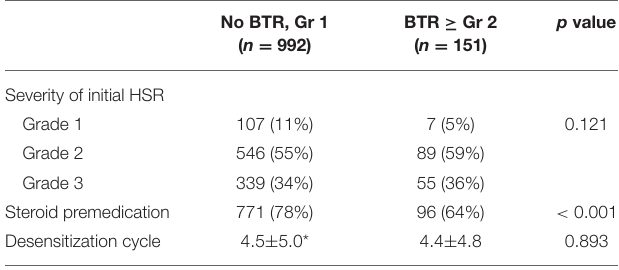
TABLE 3 | Comparison of characteristics between the procedures with no or mild BTRs and those with moderate to severe BTRs.